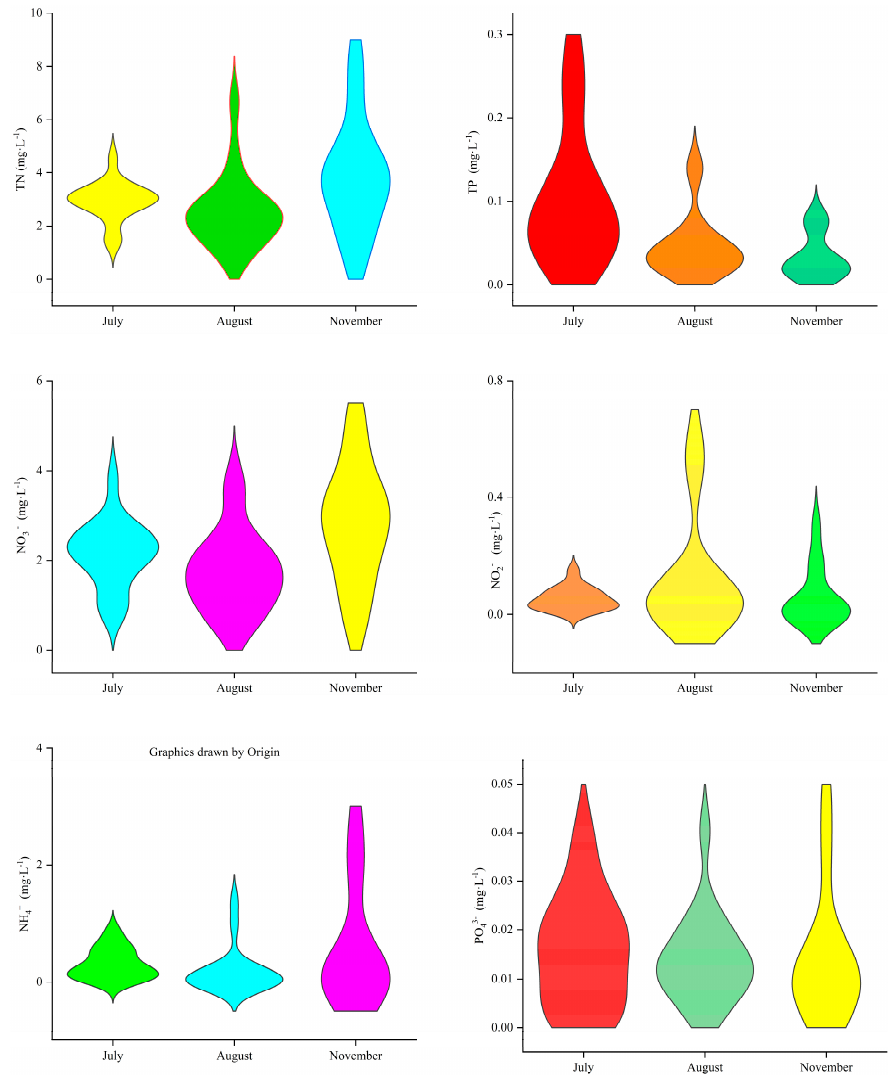
Figure 4. Nutrients concentrations at 17 locations within the Maotiao River Basin (Gizhou province, SW China) in 2020. TN: total nitrogen; NO 3 − : nitrate; NO 2 − : nitrite; NH 4+ : ammonium; TP: total phosphorus; PO 43 − : orthophosphate.